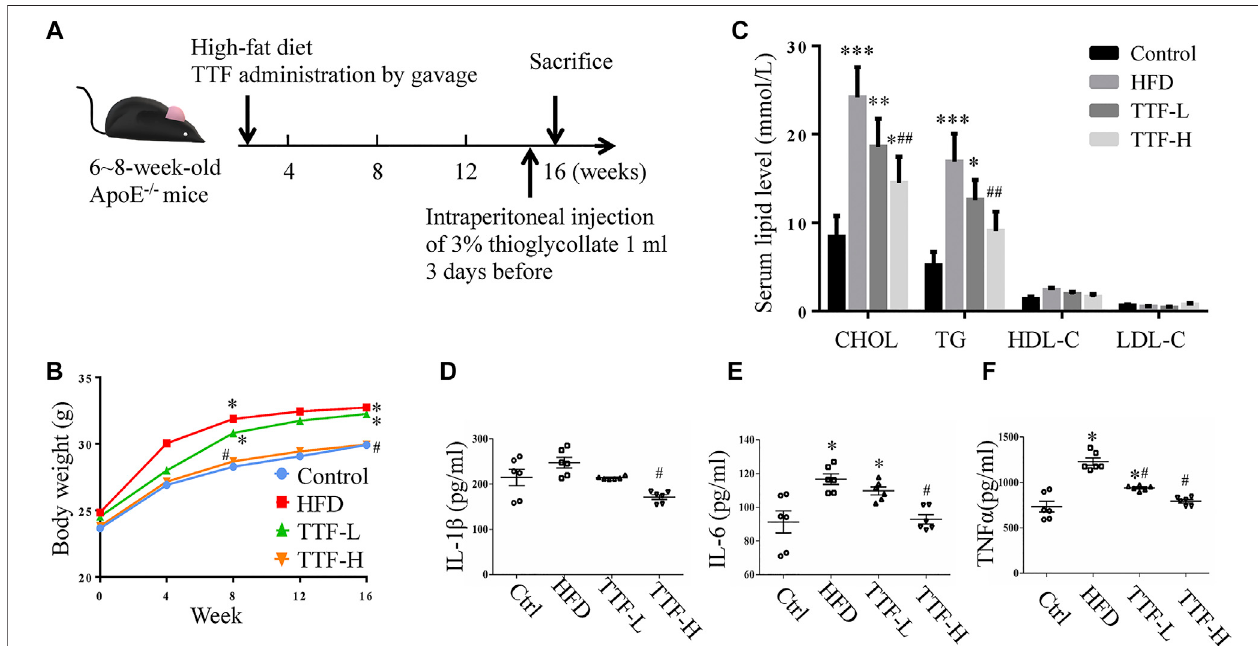
FIGURE 2 | TTF affects body weight and serum lipid level in ApoE -/- mice (A) Experimental protocol of the in vivo study (B) Curve of body weight of ApoE -/- mice. * p < 0.05vsControlgroup (C) Histogram ofserum contentofcholesterol, triglyceride, highdensity lipoproteinand low-densitylipoproteinofApoE -/- mice (D) Histogram of serum content of IL-1 β (E) IL-6, and (F) TNF- α in ApoE -/- mice. Values are presented as means ± SEM (n (cid:2) 10 per group). * p < 0.05 vs Control group, ** p < 0.01 vs Control group, *** p < 0.001 vs Control group, ## p < 0.01 vs HFD